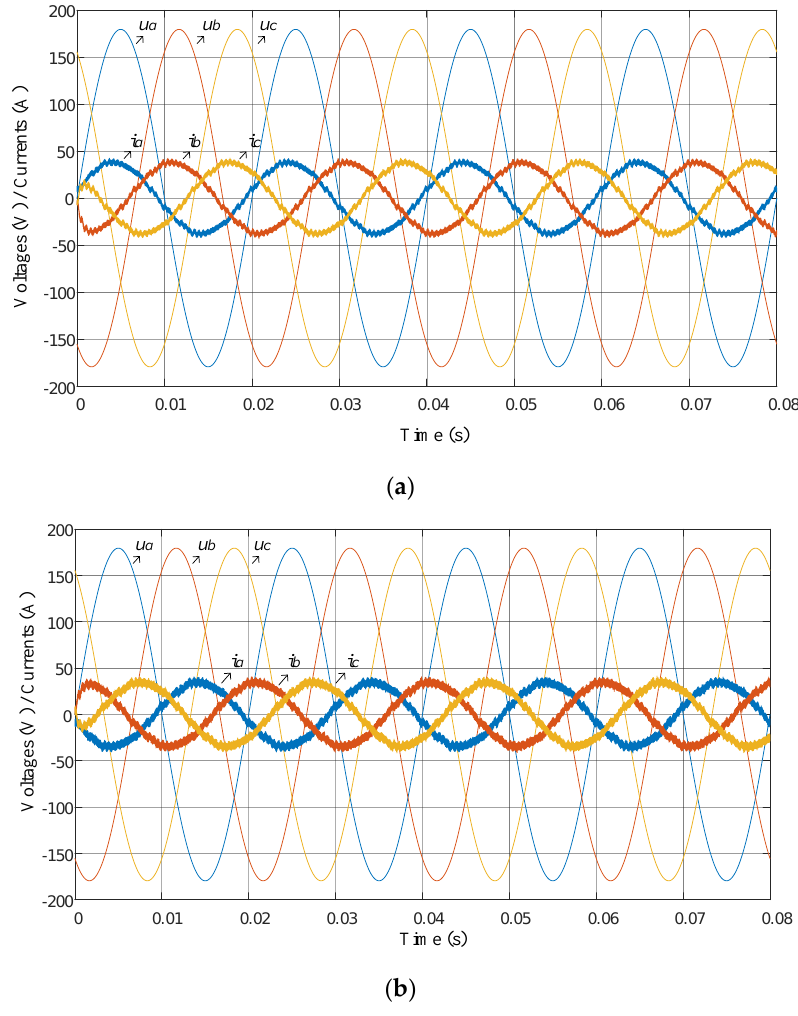
Figure 10. Three-phase voltage s and currents in ( a ) the forward direction and ( b ) the reverse direction.